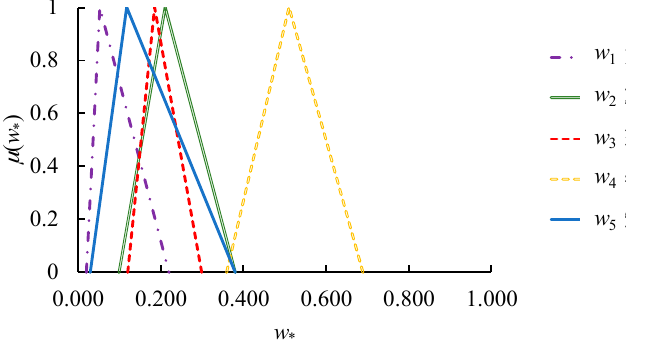
Figure 10. Approximating the partial consensus fuzzy intersection (PCFI) results with triangular fuzzy numbers (TFNs).